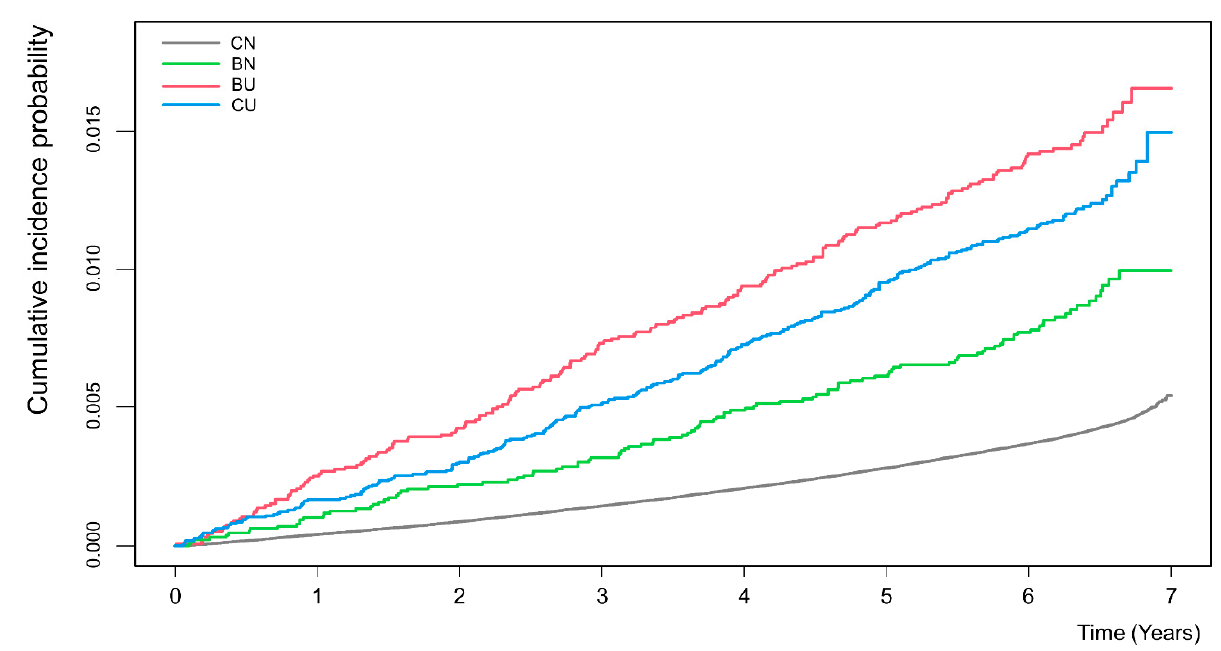
Figure 2. Estimates of cumulative incidence of hip fracture according to the change in underweight status. CN, consistent non-underweight; BN, became non-underweight; BU, became underweight; CU, consistent underweight.